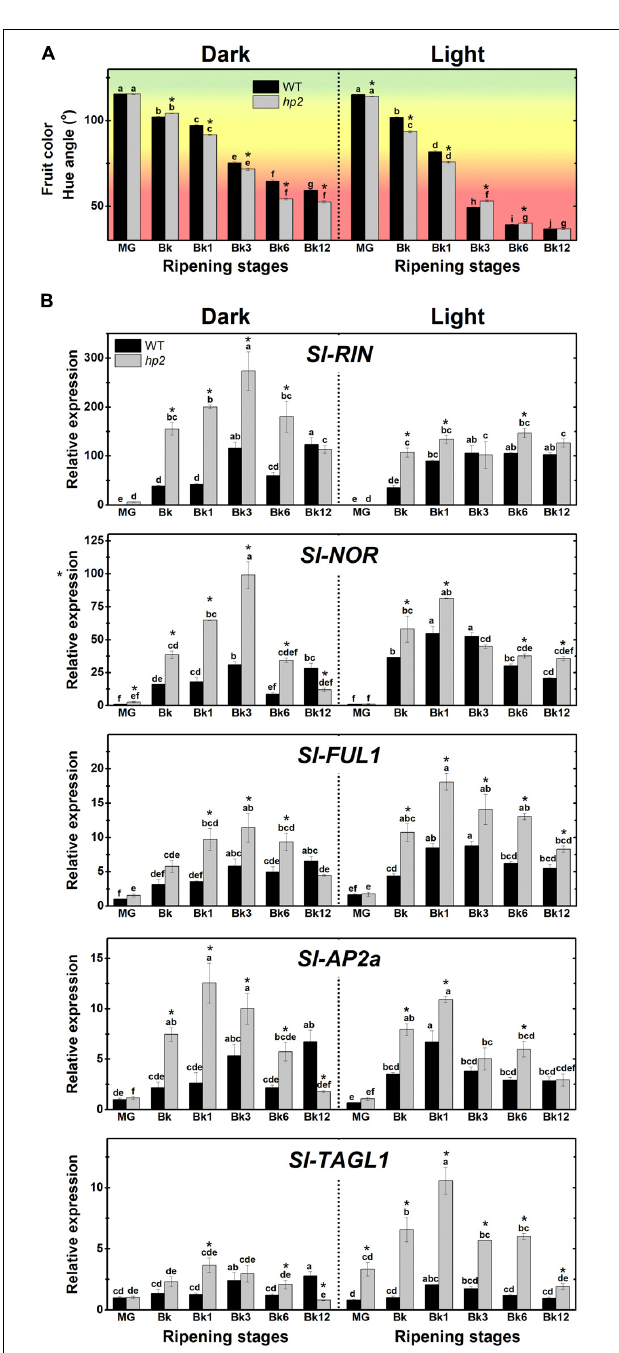
FIGURE 2 | Light signaling influences tomato fruit ripening. Treatment details as described in Figure 1 . (A) Ripening-related changes in fruit color (Hue angle). (B) Transcript abundance of ripening regulator genes in dark- and light ripened fruits. Mean relative expression was normalized against wild-type (WT) samples at mature green (MG) stage under dark conditions. Data are means ( ± SE) of at least three biological replicates. Different letters indicate statistically significant differences (Tukey’s test, p < 0.05) within each genotype. Asterisks indicate statistically significant differences (Student’s t -test, p < 0.05) between genotypes. hp2 , high pigment-2 ; Bk, Breaker; RIN, ripening inhibitor; NOR, non-ripening; FUL1, fruitfull1; AP2a, apetala2a; TAGL1, tomato